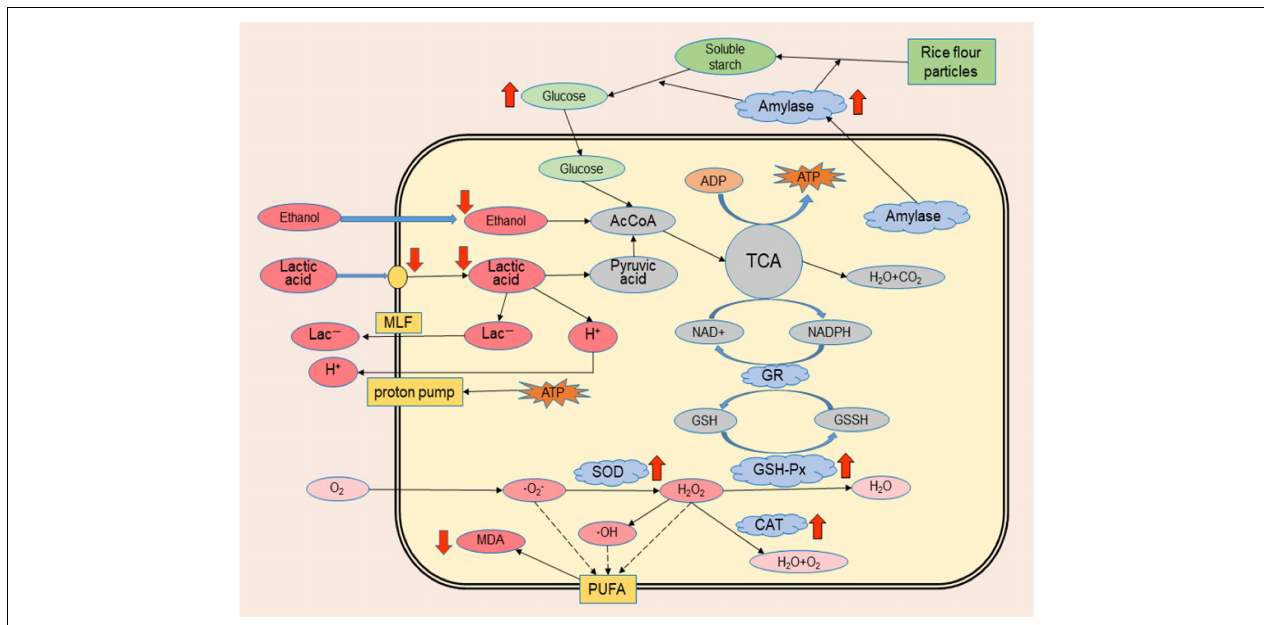
FIGURE 8 | Schematic illustration of the possible tolerance mechanism of Monascus to synergistic stress of lactic acid and ethanol. Red arrows indicate significant metabolic differences between Monascus and other fungi isolated from BHQ33 in the optimized restrictive medium containing both lactic acid and ethanol, with arrows up-regulated and arrows down-regulated.